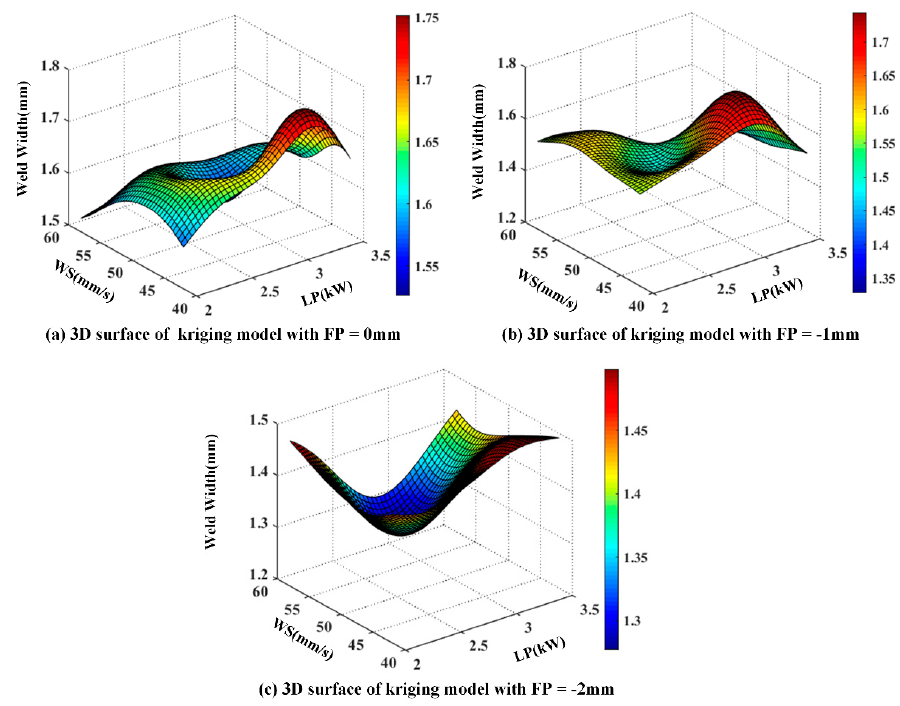
Figure 7. The kriging model for weld width prediction.